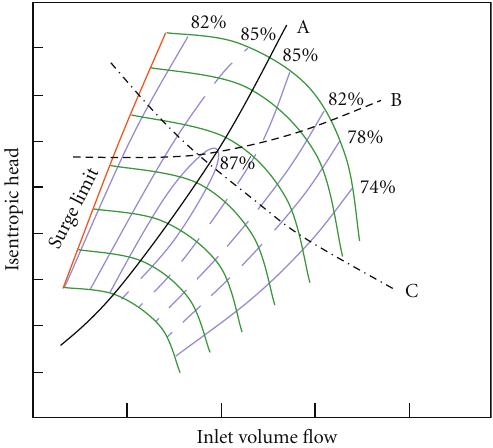
Figure 2: System characteristics and compressor